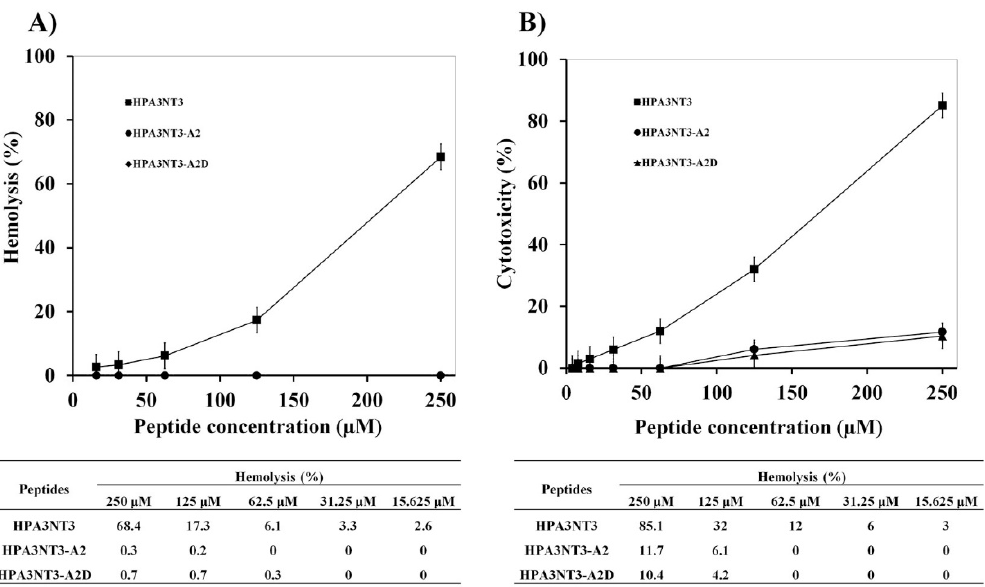
Figure 1. Toxicity of HPA3NT3 and its analogue peptides against RBCs ( A ) and HaCa T ( B ) cells. Error bars indicate SD ( p < 0.005).